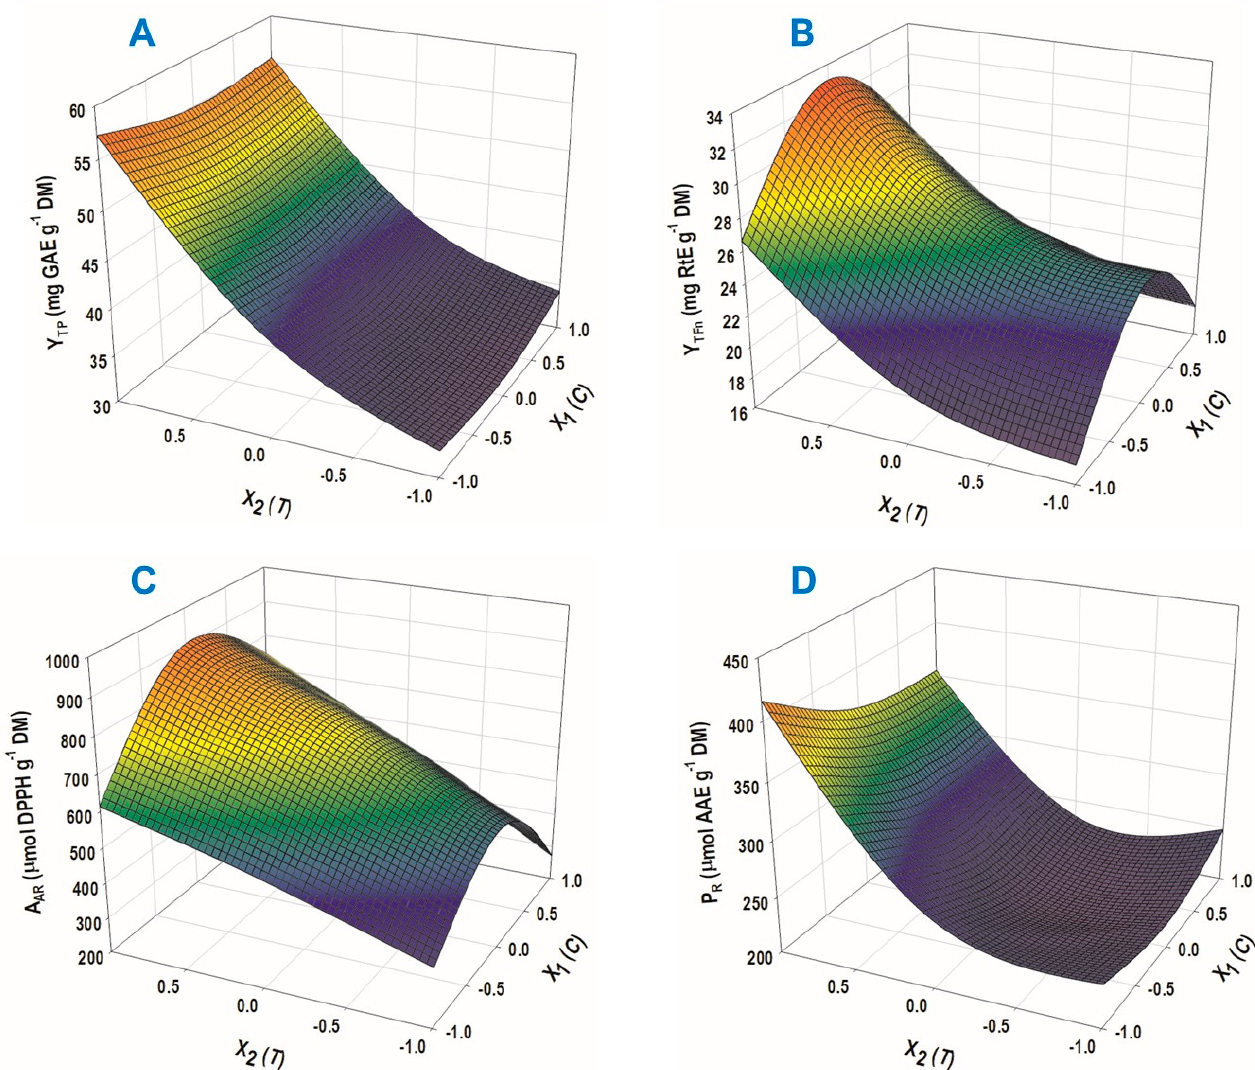
Figure 2. Three-dimensional diagrams showing the effect of independent (process) variables on the responses considered. ( A ), effect on Y TP ; ( B ), effect on Y TFn ; ( C ), effect on A AR ; ( D ), effect on P R . With reference to temperature, the optimization for all responses showed that the values were maximized at 80 °C (Table 4). This was in line with a recent thorough investigation, which suggested 76 °C to be the optimum T for polyphenols extraction from mint, using various solvents, such as water, aqueous ethanol, aqueous glycerol, and a deep eutectic solvent [18]. Optimizing A AR and P R required 80 °C was also strong evidence that no loss of antioxidant activity occurred at this temperature. However, an optimum temperature of as low as 50 °C has also been reported for peppermint extractions performed with water/glycerol mixtures [26].